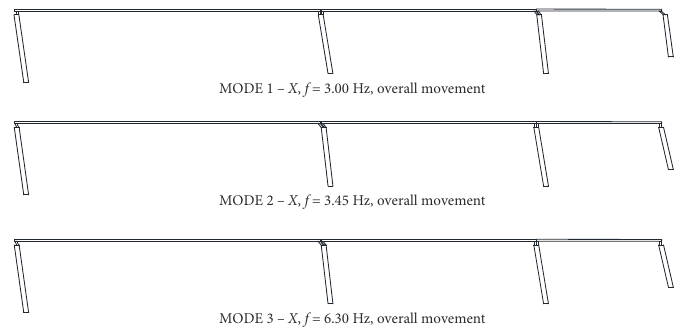
Figure 15. Obtained mode shapes in X direction in the second Ambient Vibration